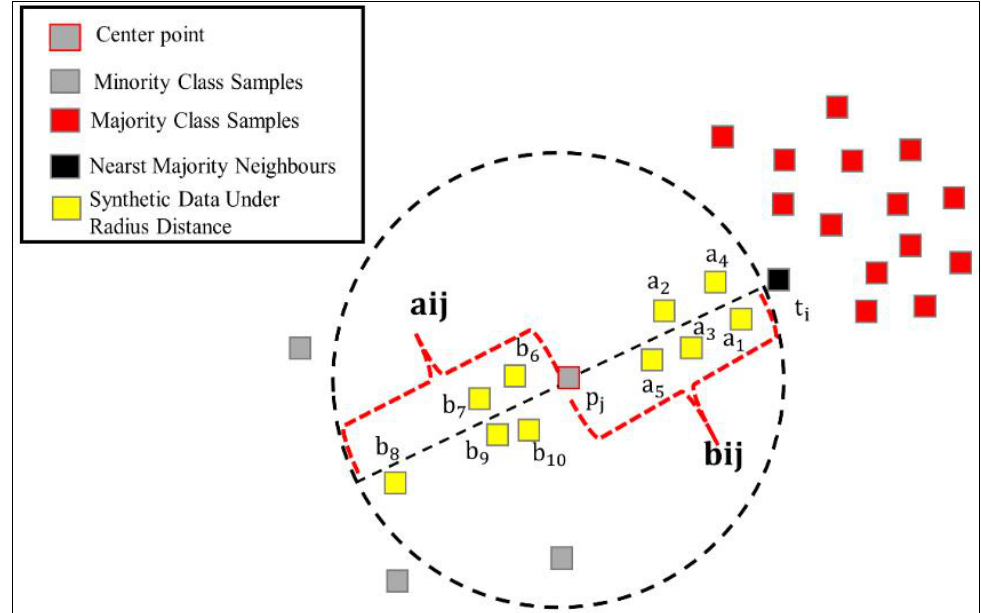
Figure 5. Illustration of calculating radius distance based on circle formulation for restricting new generated synthetic data (𝑡 ) is the closest majority point to the center of the circle ( 𝑝 where 𝑡 , 𝑡 , 𝑡 , … 𝑡 𝑖 1 2 3 𝑛 each minority sample is calculated from the majority class using the Euclidean distance method. The closest majority data point has a minimum distance to the minority data point, as shown in Equation